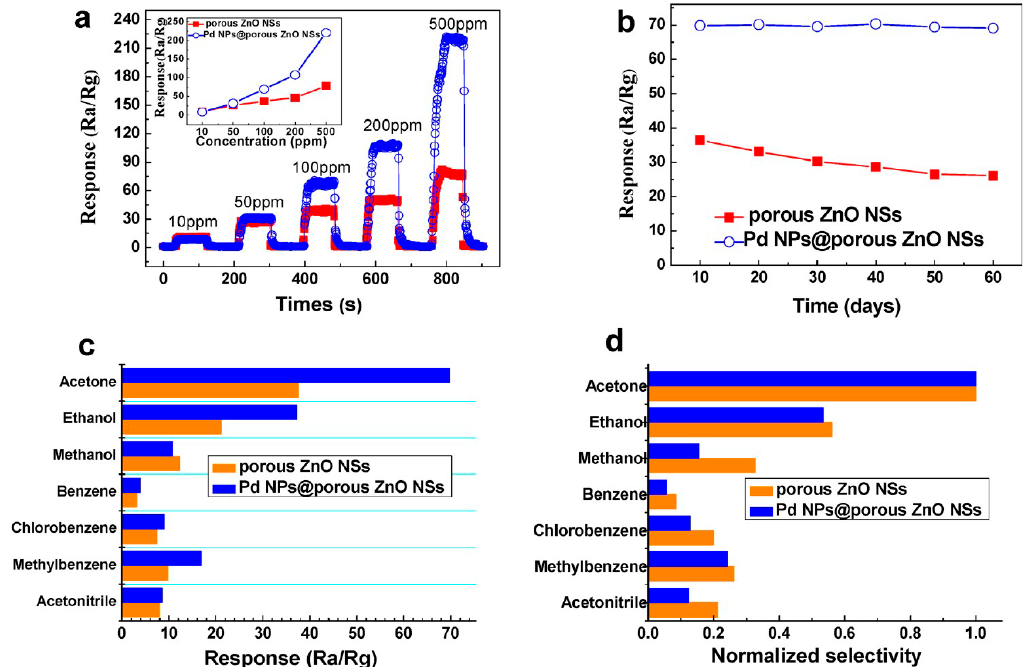
Figure 12. ( a ) Dynamic responses to acetone at concentrations ranging from 10 to 500 ppm of acetone sensors made with Pd − ZnO − Nnanosphere and ZnO − nanosphere at optimized operating temperatures. The inset shows response vs concentration curves of the corresponding sensors; ( b ) Stability studies of sensors exposed to 100 ppm acetone; ( c ) The selectivity of the acetone sensors to reducing gases; and ( d ) The corresponding normalized selectivity of sensors from (c). Adapted figure from [92] with permission from copyright (2012), American Chemical Society (Washington, DC, USA).